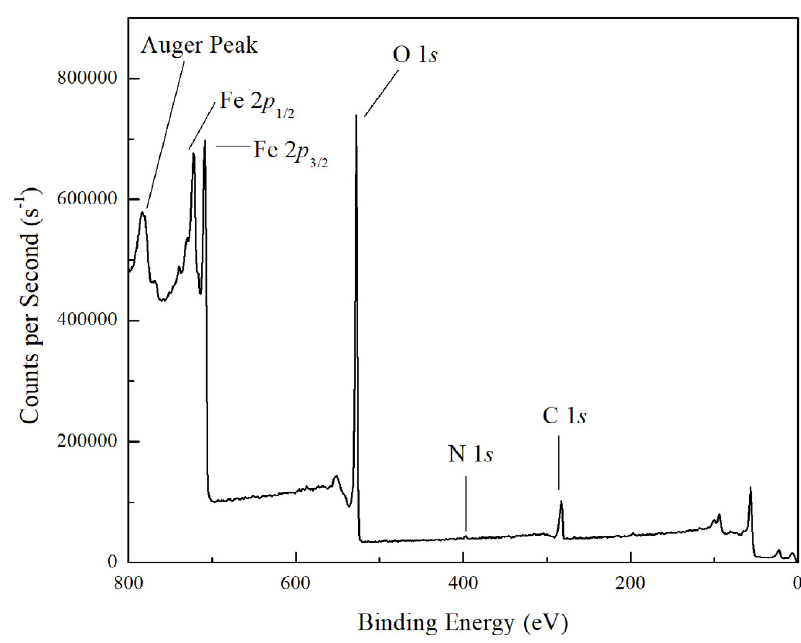
Fig. 7. XPS spectra survey scan of the PostE